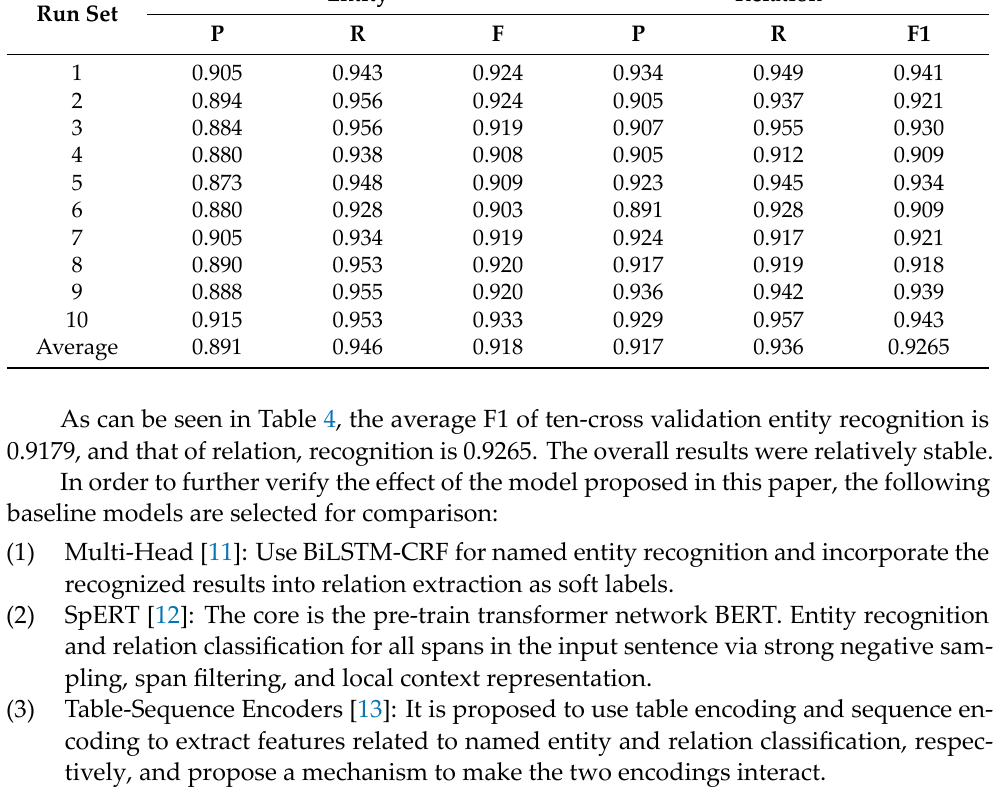
Table‑Sequence Encoders [13]: It is proposed to use table encoding and sequence en‑ coding to extract features related to named entity and relation classification,